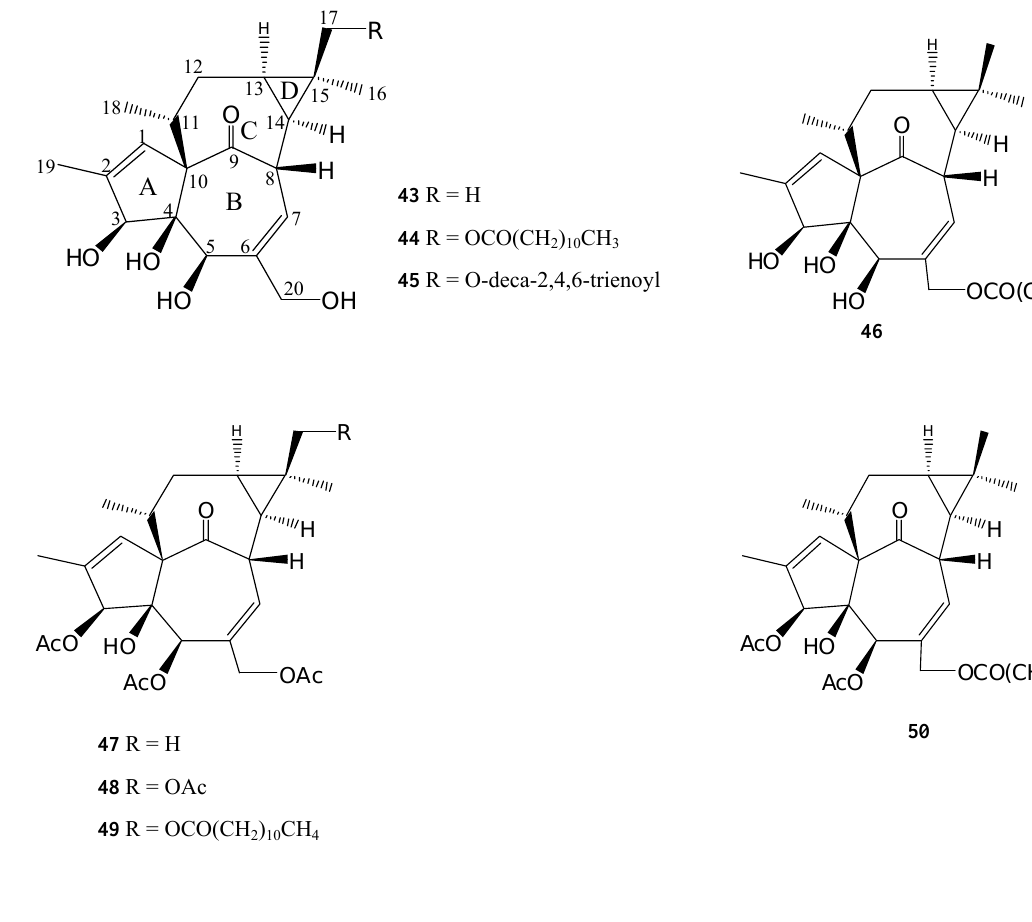
Figure 2. Ingenane Diterpenoids Isolated from Euphorbia